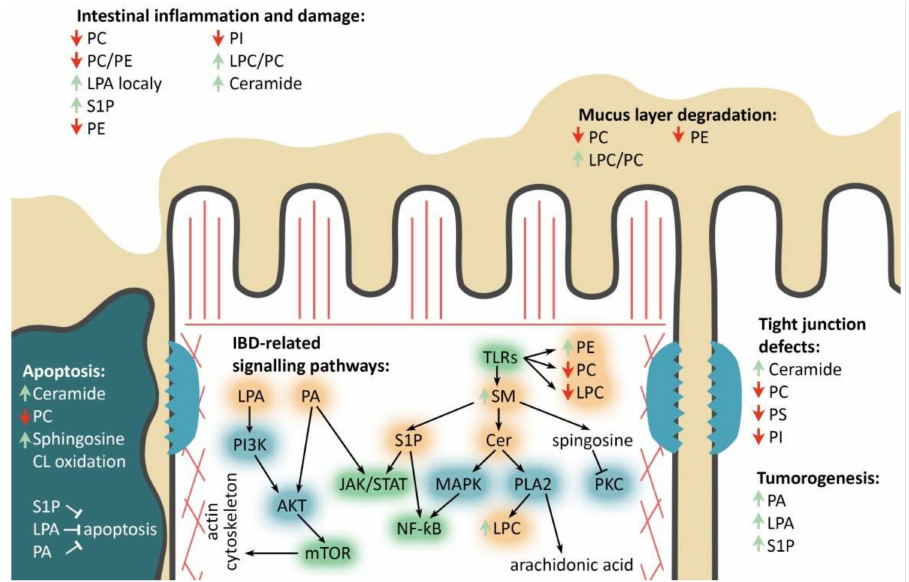
Figure 3. Major phospholipids’ roles in the enterocyte during IBD. PC/PE/PS/PI—phosphatidylcholine/-ethanolamine/- serine/-inositol, LPC-lysophosphatidylcholine, (L)PA—(lyso)phosphatidic acid, SM—sphingomyelin, Cer—ceramide, S1P—sphingosine-1-phosphate, IBD-related signaling pathways: TLRs—toll-like receptors pathway, mTOR—mammalian target of rapamycin pathway, JAK/STAT—Janus kinases/signal transducer and activator of transcription proteins pathway, NF-kB-nuclear factor kappa-light-chain-enhancer of activated B cells. Phospholipids’ remodeling and other involved enzymes: PI3K—phosphoinositide 3-kinase, AKT—protein kinase B, PLA2—phospholipase A2, PKC—protein kinase C, MAPK—mitogen-activated protein kinase. Red and green arrows refer to decrease and increase in corresponding phospho- lipids, respectively. Black arrows and blind-ended arrows show stimulatory and inhibitory effects in lipids,